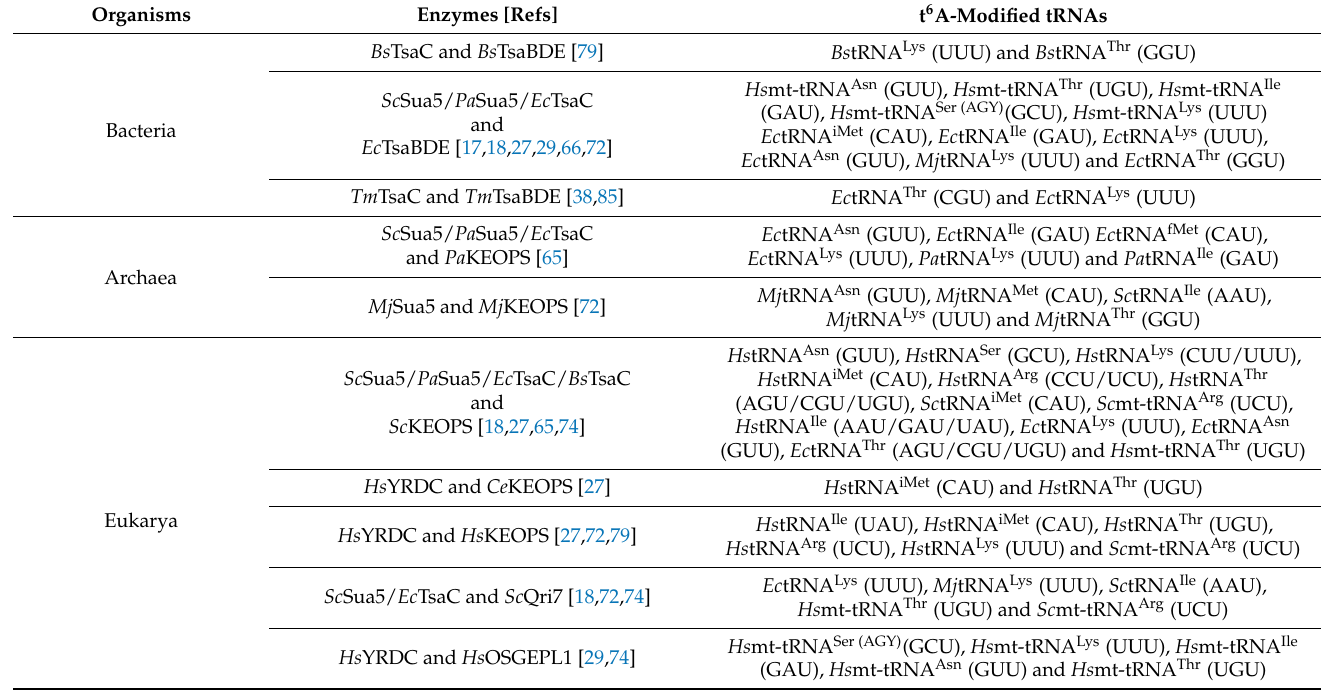
Table 3. Summary of enzymatically validated tRNA t 6 A-modifying enzymes and tRNA substrates. Abbreviations: Bs , Bacillus subtilis ; Sc , Saccharomyces cerevisiae ; Hs , Homo sapiens ; Ec , Escherichia coli